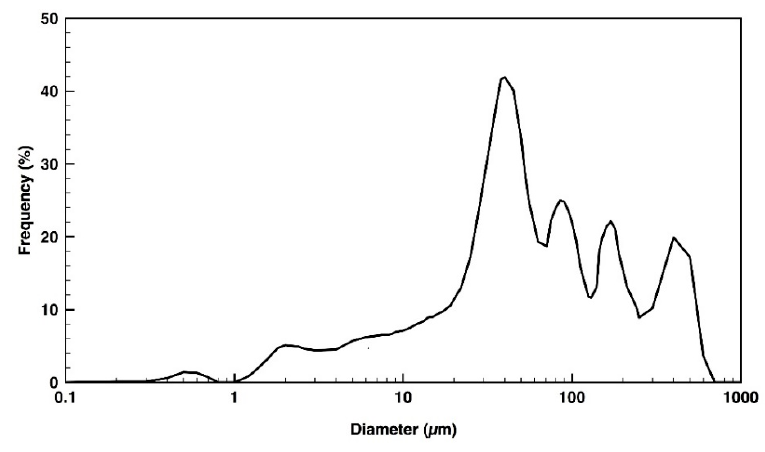
Figure 3. Dog wool microparticle size distribution.